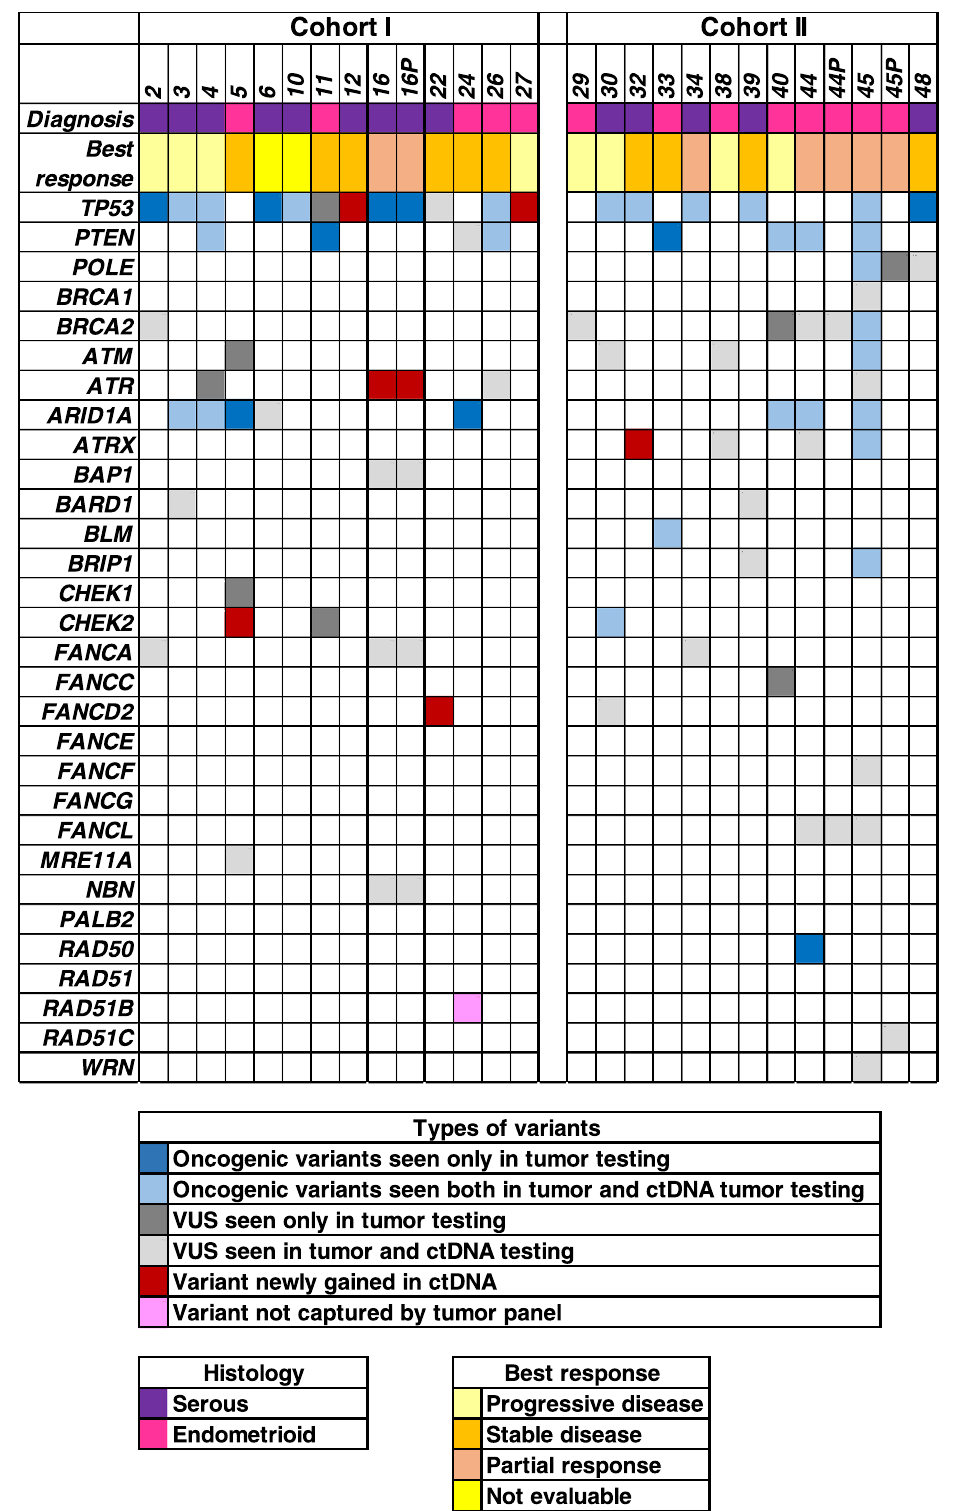
Fig.4|Oncoprintrepresentingdistributionofoncogenicandvariantsofuncertainsigni fi cance(VUS)inctDNAatbaseline. Cohort1includespatientidenti fi cations listed as NEC-2 – 27 ( n =13), and Cohort 2 includes patient identi fi cations listed as NEC-29 – 48 ( n =11). p: second